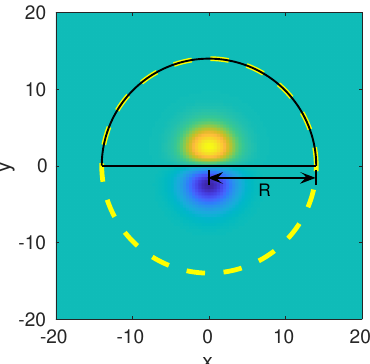
Figure 2 . Regions (viewed on the z = 0 slice) used to define E , Q , E c , Q s Q up and Q +